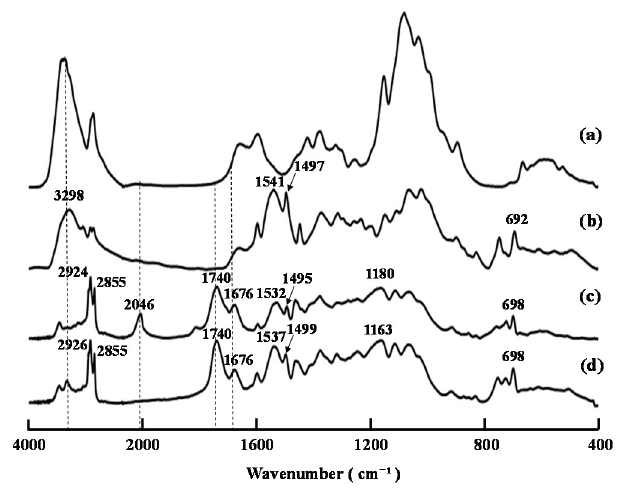
Figure 1. FT-IR spectra of compounds (a) 1 , (b) 2 , (c) 3b (product ( A )), and (d) 4 .